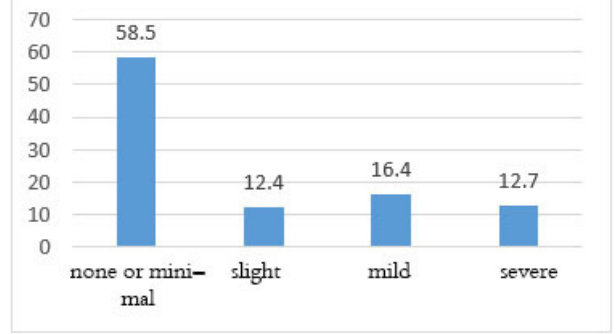
Table 1. Frequency and percentage of responding to questions Figure 1. Degree of depression among the Thalassemic PercentFrequen- cyLevelVariable